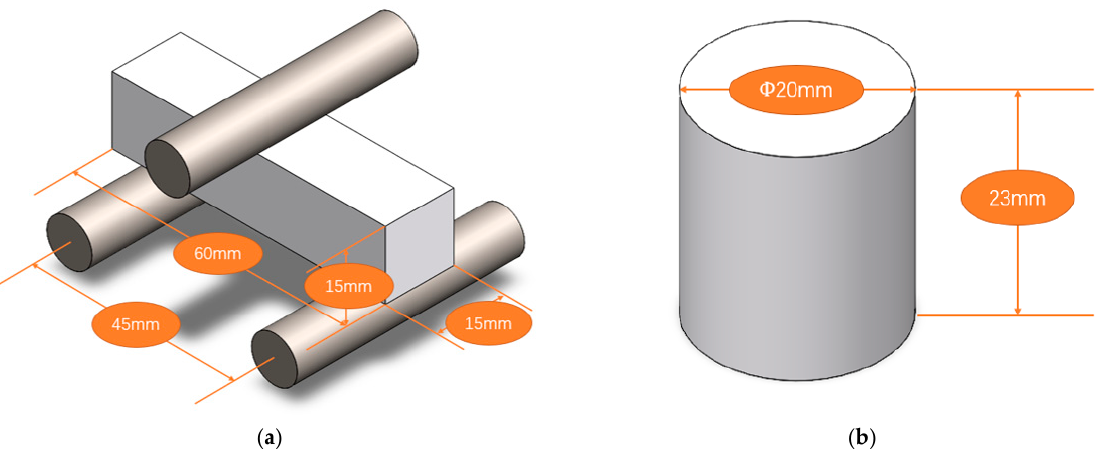
Figure 2. Specimen size for mechanical property testing: ( a ) configuration of three-point bending, ( b ) compressive strength test sample dimensions.